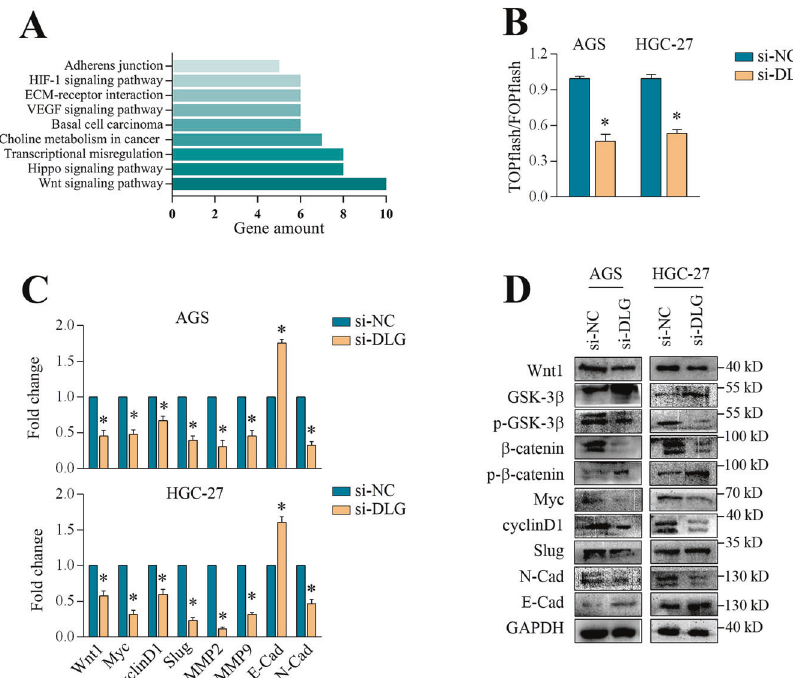
Fig. 3 DLGAP1-AS2 modulated the Wnt/ β -catenin pathway in GC. A KEGG pathway analysis for DLGAP1-AS2 co-expressed genes from TCGA dataset. B TOP fl ash/FOP fl ash assays in AGS and HGC-27 cells upon DLGAP1-AS2 knockdown. C RT-qPCR assays for the expression of Wnt1 and its downstream targets upon DLGAP1-AS2 knockdown. D Western blot analysis of the main factors related to Wnt/ β -catenin signaling upon DLGAP1-AS2 knockdown. The data shown are representative of three independent experiments. E-Cad E-cadherin, N-Cad N-cadherin. * P <